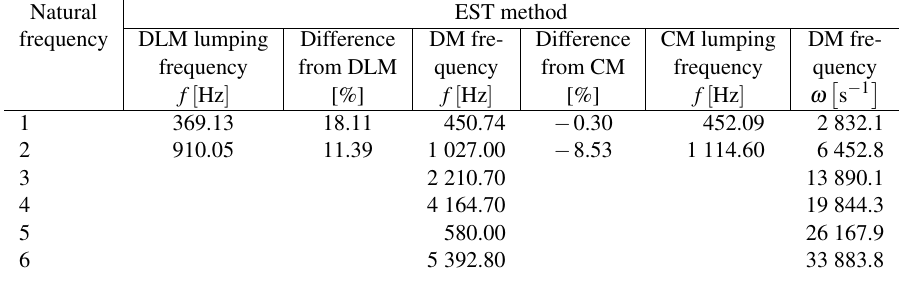
Table 1. Natural frequencies of the truss